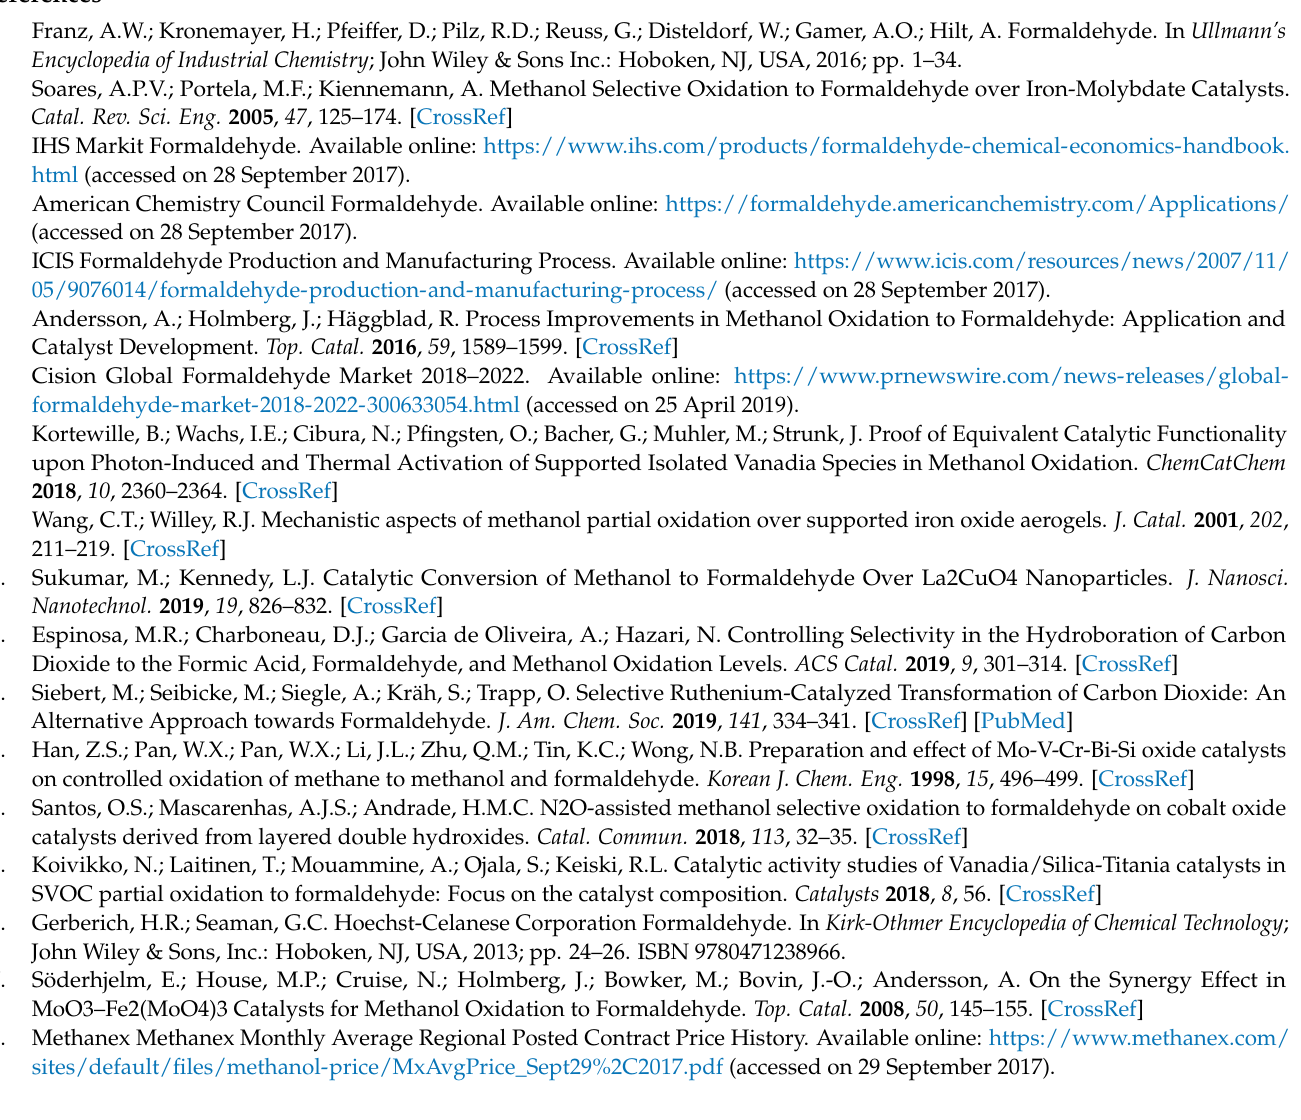
CH3OH, Table S11: Pre-exponential factor (k0) and activation energy (Ea) of catalysts not containing molybdenum or